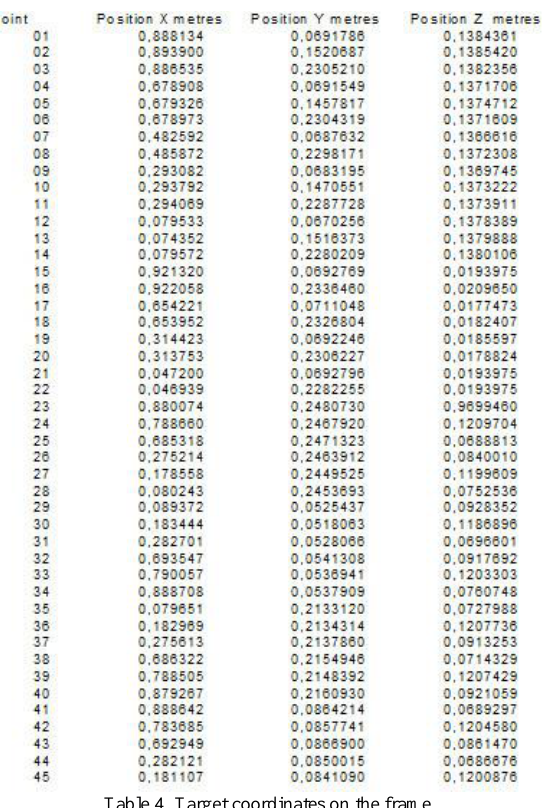
Table 4. Target coordinates on the frame